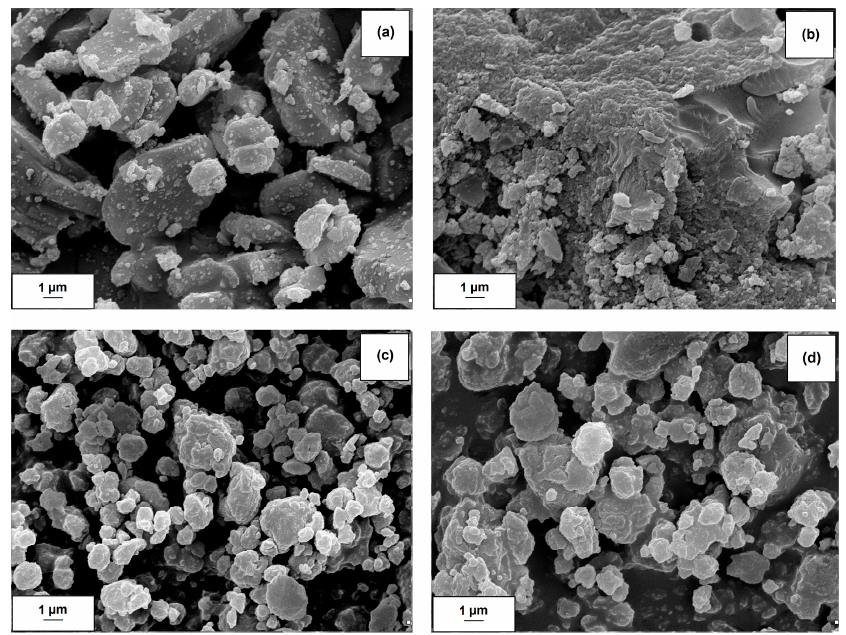
Figure 1. SEM images of alumina ( a ); lignin ( b ) and lignin-alumina hybrid materials (8:1, wt / wt ) ( c ) and (8:6, wt / wt ) ( d ). Table 1. Dispersive characteristic of pure alumina and lignin-alumina hybrid fillers. Sample